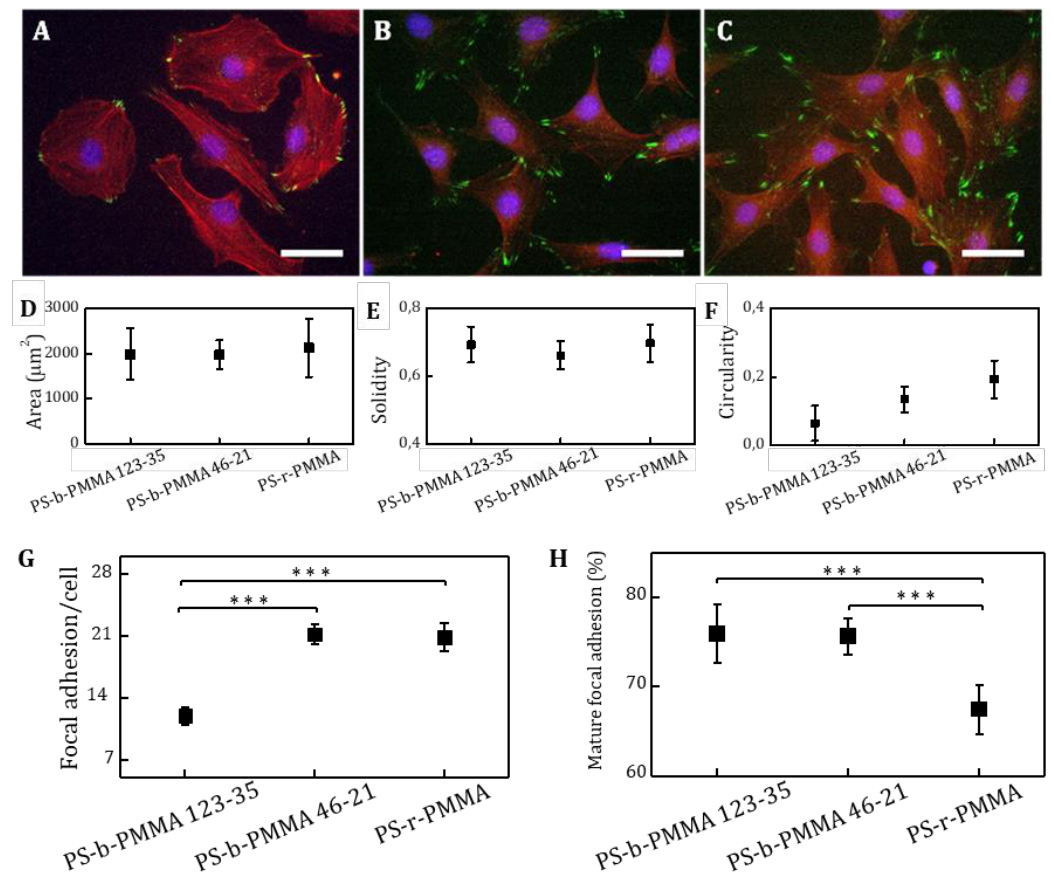
Figure 7. Representative fluorescence microscopy images of NIH/3T3 fibroblast cells plated on ( A ) PS-b-PMMA 123-35, ( B ) PS-b-PMMA 46-21, and ( C ) PS-r-PMMA after c(RGDfK)-PEG 3 -NH 2 ligand functionalization and BSA passivation under starving conditions (nuclei in blue, actin fibers in red and focal adhesion contacts in green). Scale bar, 25 µ m. Morphological parameters of the adhered cells: ( D ) projected cell area, ( E ) solidity, and ( F ) circularity after 4 h of cell. Focal adhesion analysis: ( G ) number of focal adhesions per cell and ( H ) percentage of mature focal adhesions (*** denotes statistical significance level p < 0.001; error bars represent the standard error of the mean).